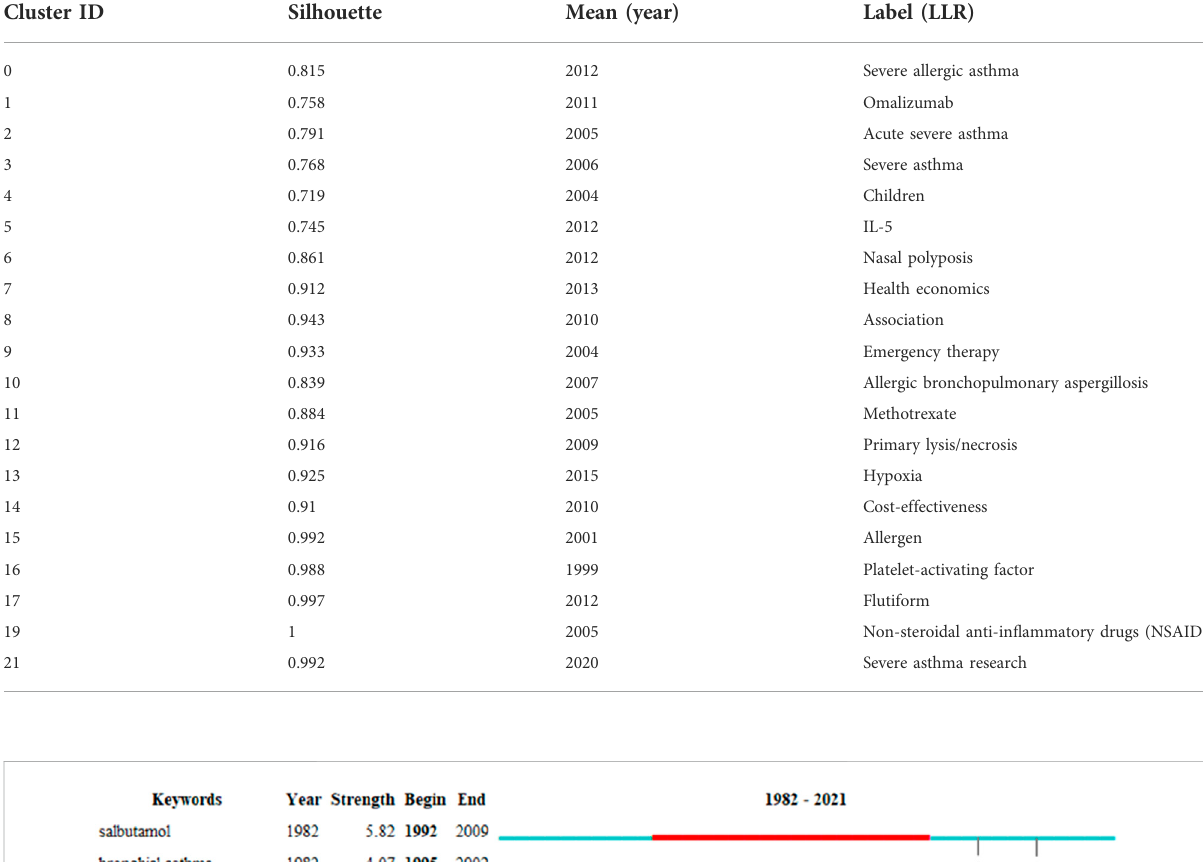
TABLE 5 Co-occurrence map of severe asthma drug-related study keyword cluster analysis.